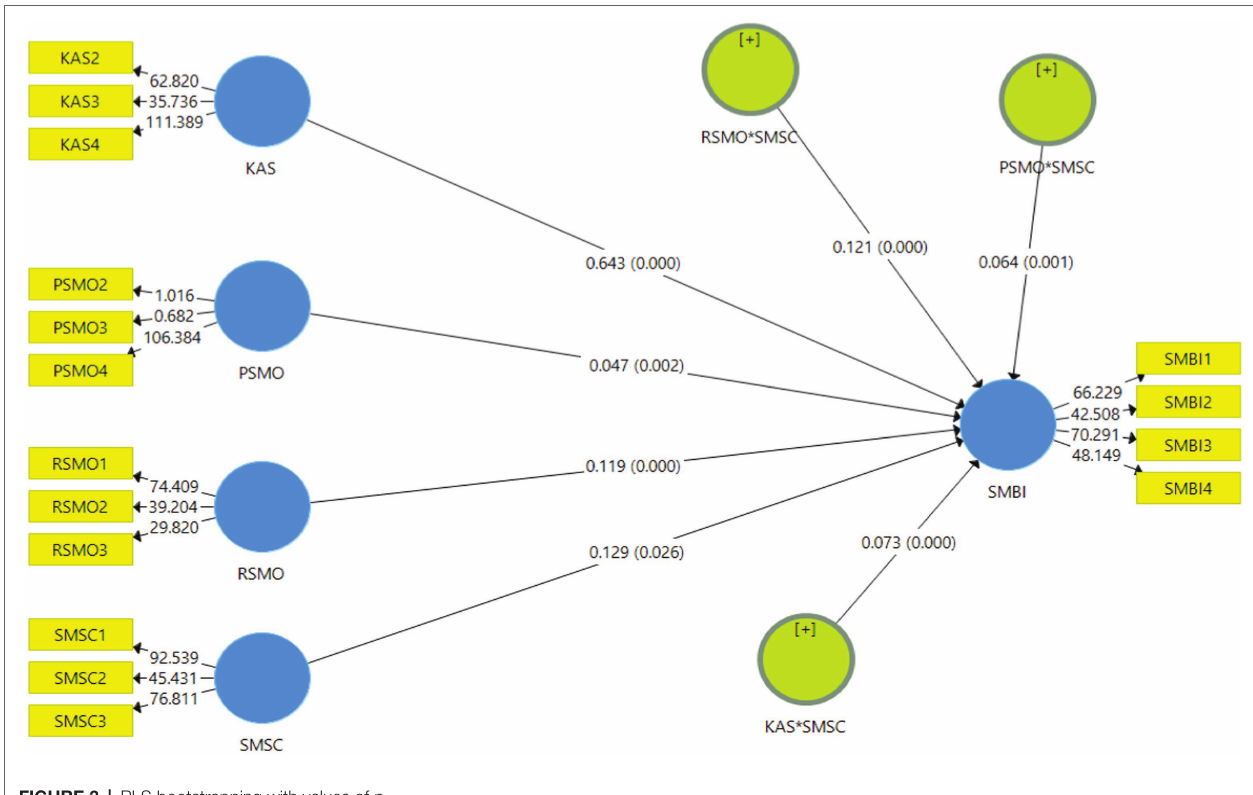
FIGURE 3 | PLS bootstrapping with values of p .